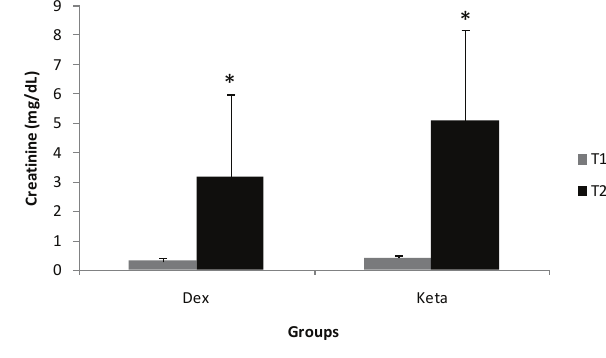
FIGURE 1 - Mean and standard deviation of blood creatinine according to time point (T1 = before ischemia, and T2 = after 48h of reperfusion) and group. * = p<0.05, so